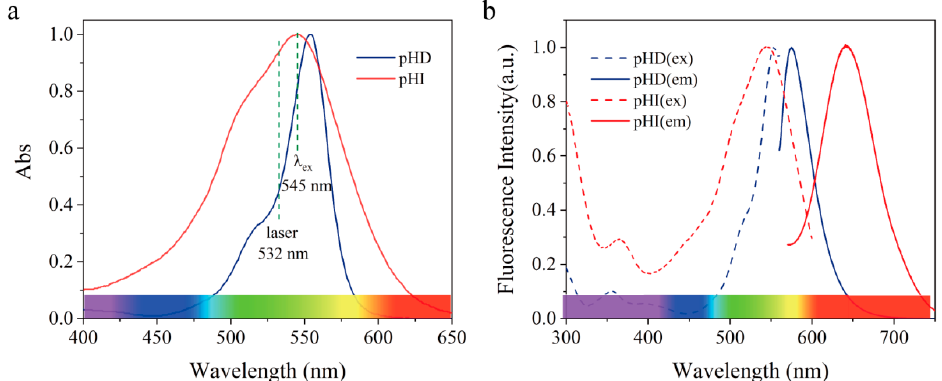
Figure 2. ( a ) Normalized absorption spectra of pHD and pHI. ( b ) Normalized excitation and emission spectra of pHD and pHI. pHD and pHI are separately dispersed in BR buffer solution at pH 3.0 and 9.0.